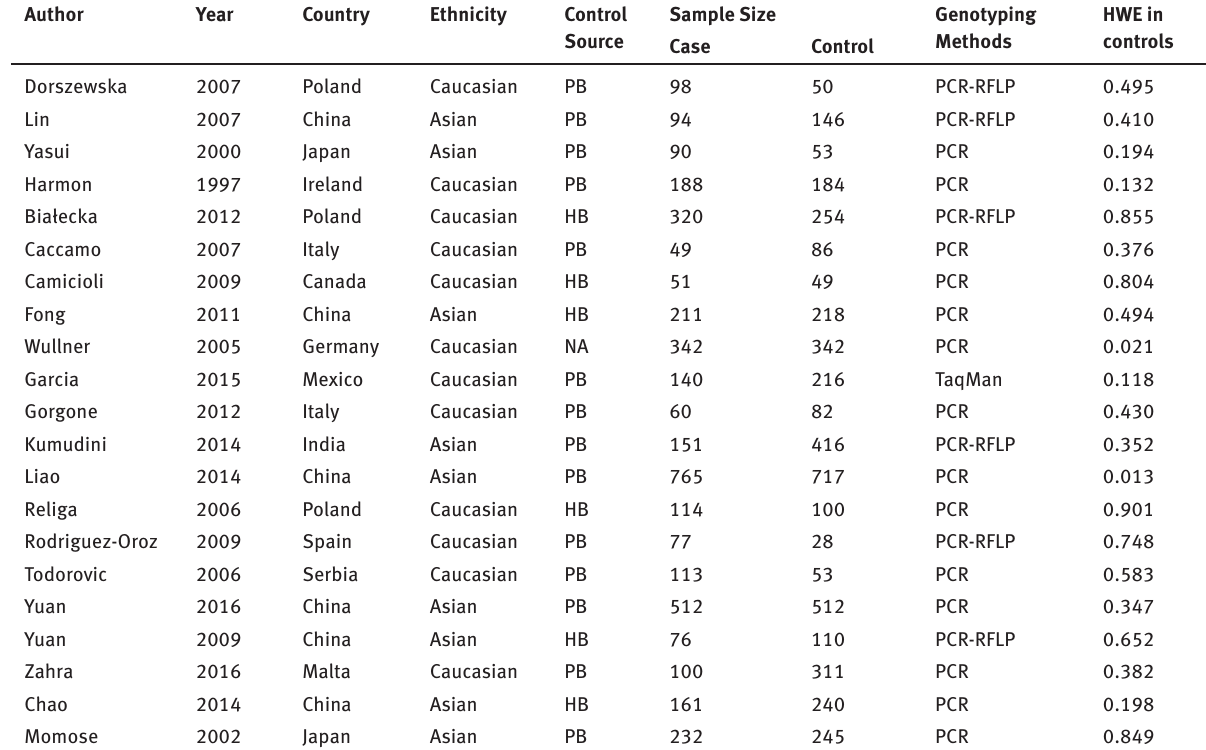
Table 1 : Main characteristics of included studies in this meta-analysis.